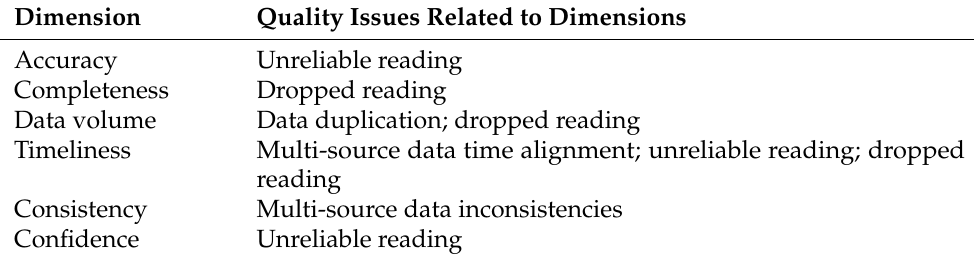
Table 8. Quality issues related to